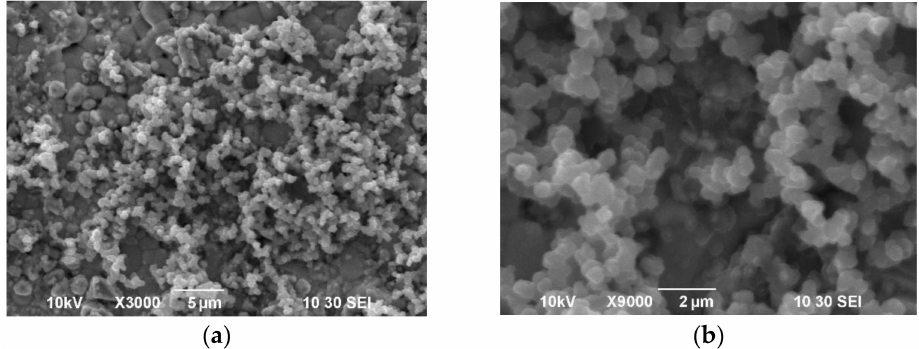
Figure 7. SEM images of the surface of a PPy coating on a non-conductive dense SDC substrate: ( a ) × 3000; ( b ) ×